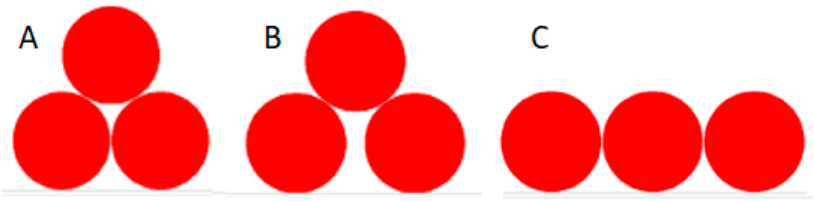
Figure 4. Analyzed cable laying formations. ( a) – ideal trefoil formation, ( b) – degraded trefoil formation, ( c) – flattened trefoil formation.